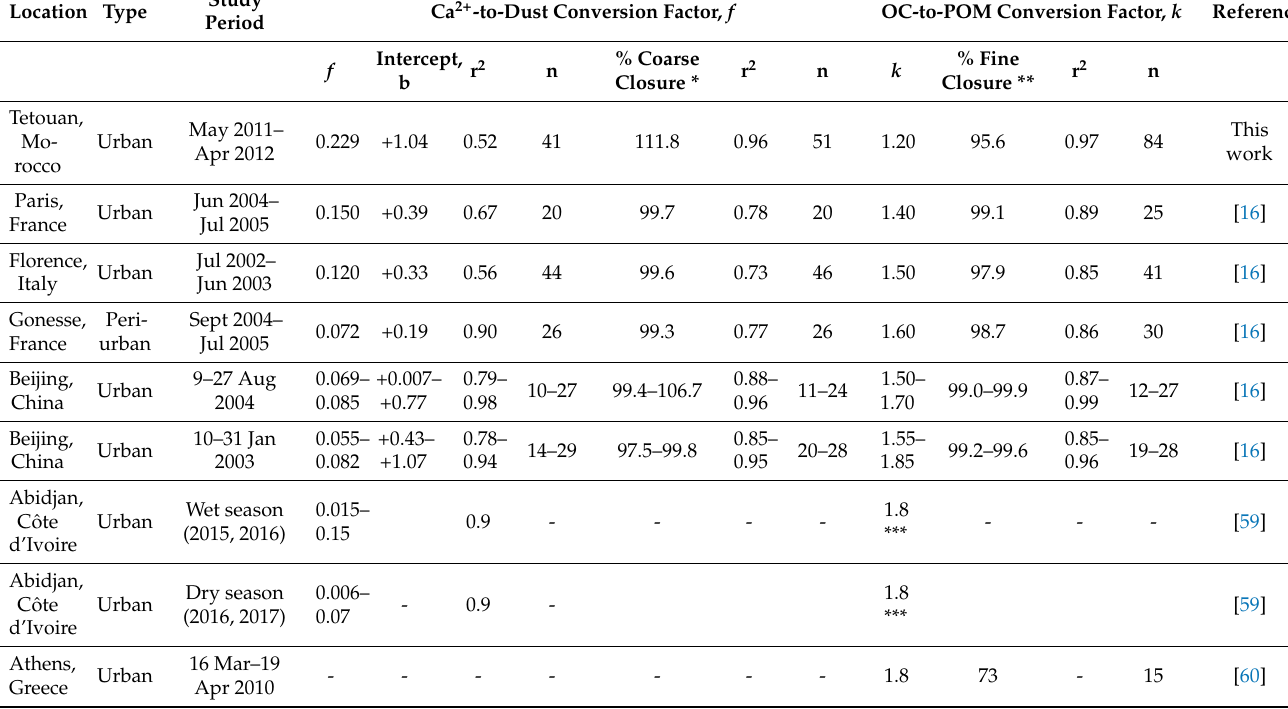
Table 3. Comparison of k (OC-to-POM conversion factor) and f (Ca 2+ -to-dust conversion factor) estimation results with different field experiments. The table is ordered according to k values. * Coarse- mode mass closure efficiency using f ; ** fine-mode mass closure efficiency where f fine = f